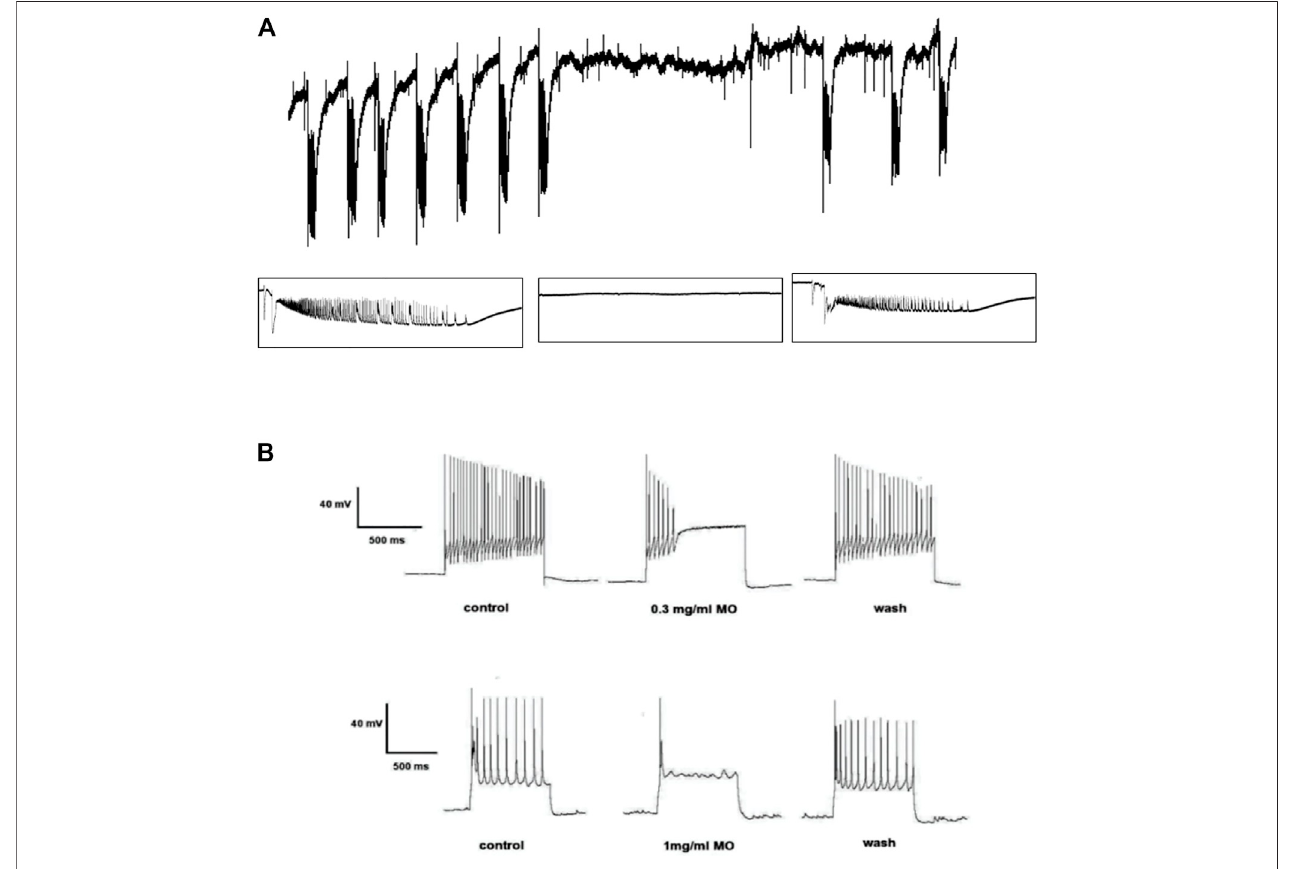
FIGURE 1 | Effects of Melissa of fi cinalis L. essential oil (MO) on (A) 4-aminopyridine-induced seizures in the rat brain slice, the tracing showing ictal events before, duringandafterapplicationofMO. (B) sustainedrepetitive fi ringincurrentclampedneurons,tracingshowingthepronouncedeffectsofMOonsustainedrepetitive fi ring before, during and after its